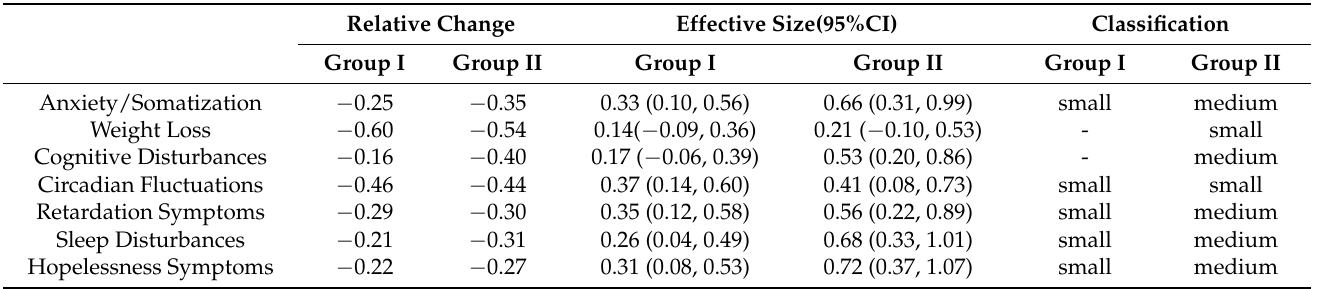
Table 4. Relative change and effective size of HAM-D 24 subitems in group I and group II. Relative